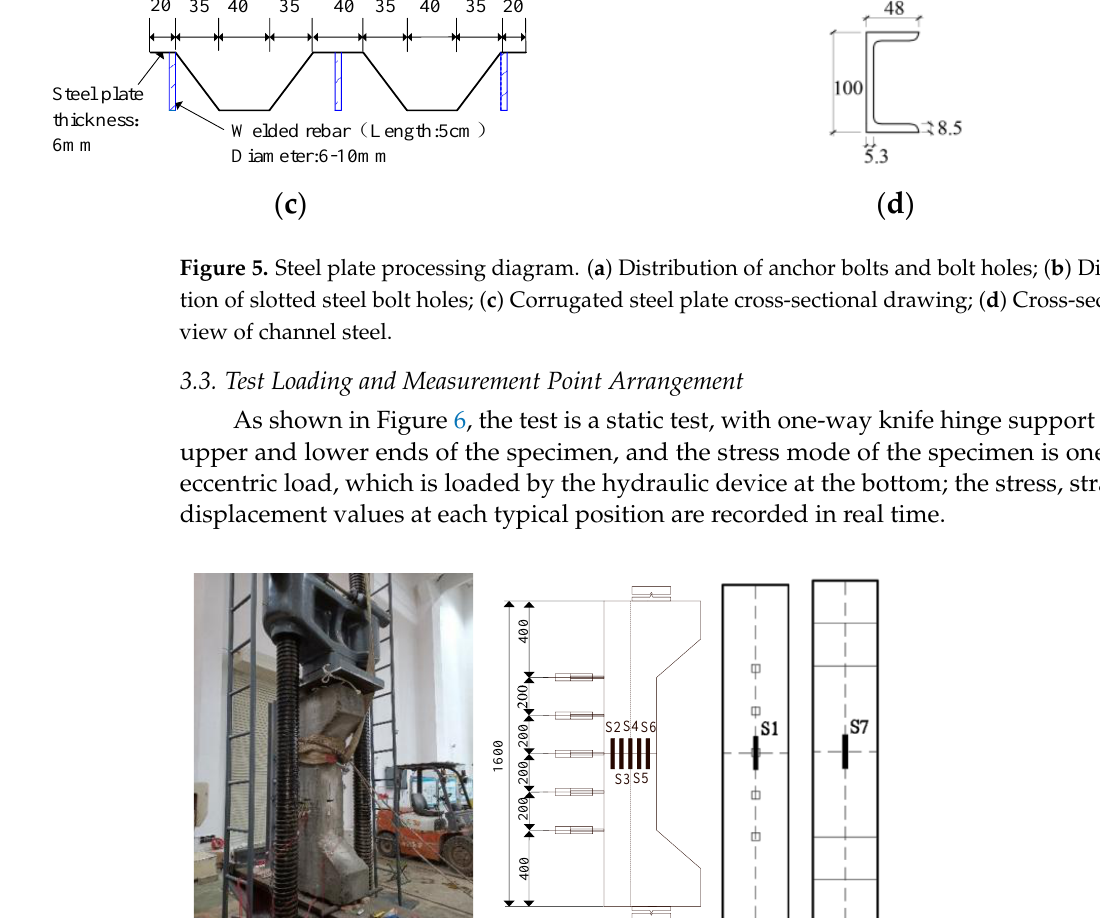
Figure 6. Specimen loading and measurement point arrangement diagram. ( a ) Loading map; ( b ) Side; ( c ) Pulled side; ( d ) Pressurized side.